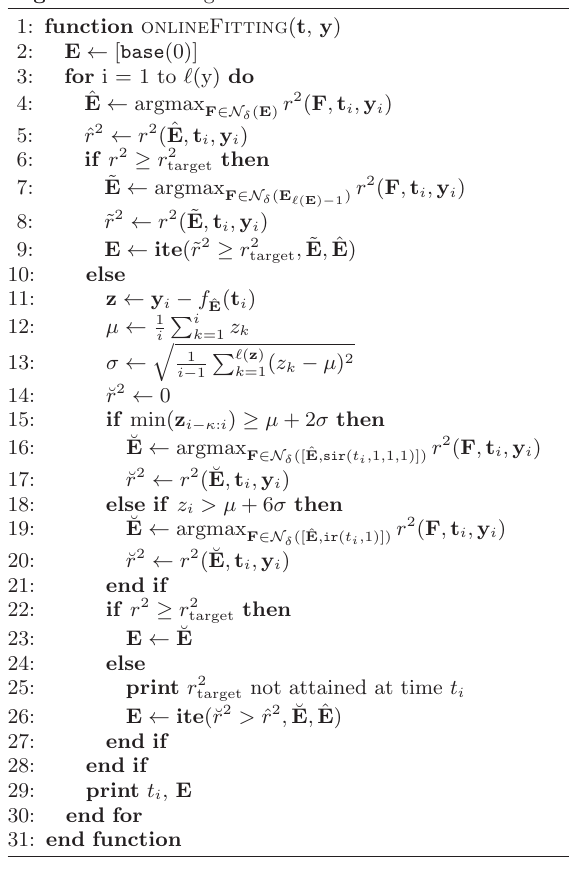
Algorithm 1 Fitting Process